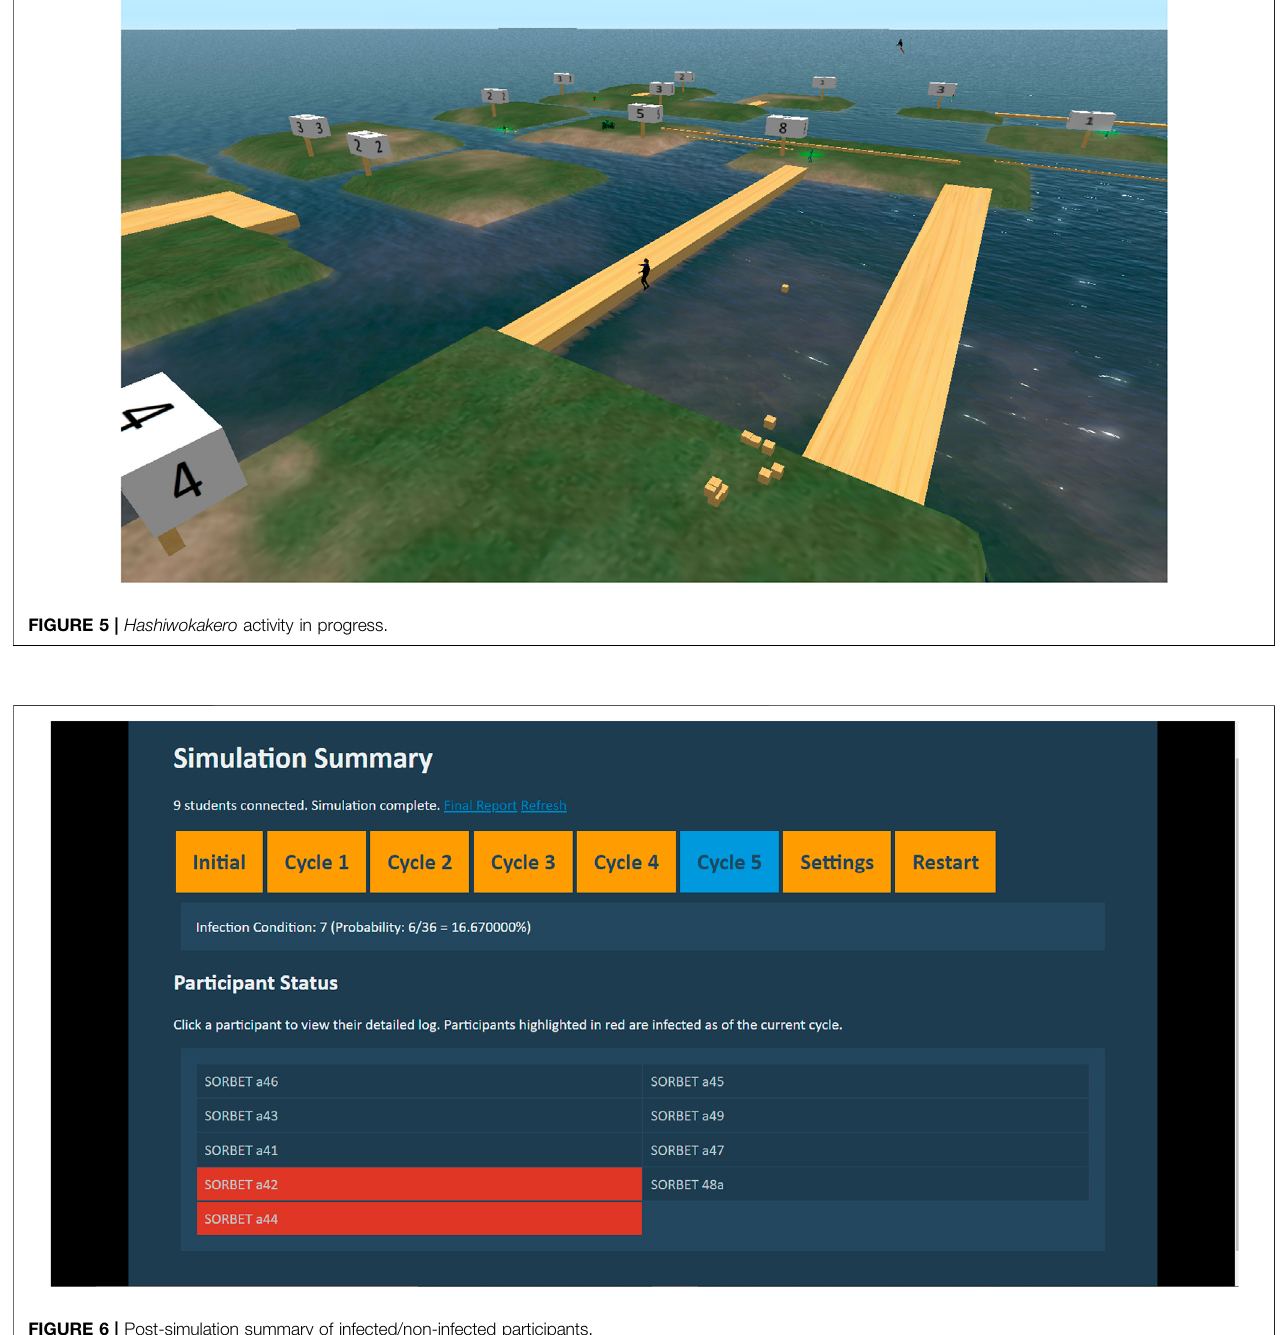
FIGURE 6 | Post-simulation summary of infected/non-infected